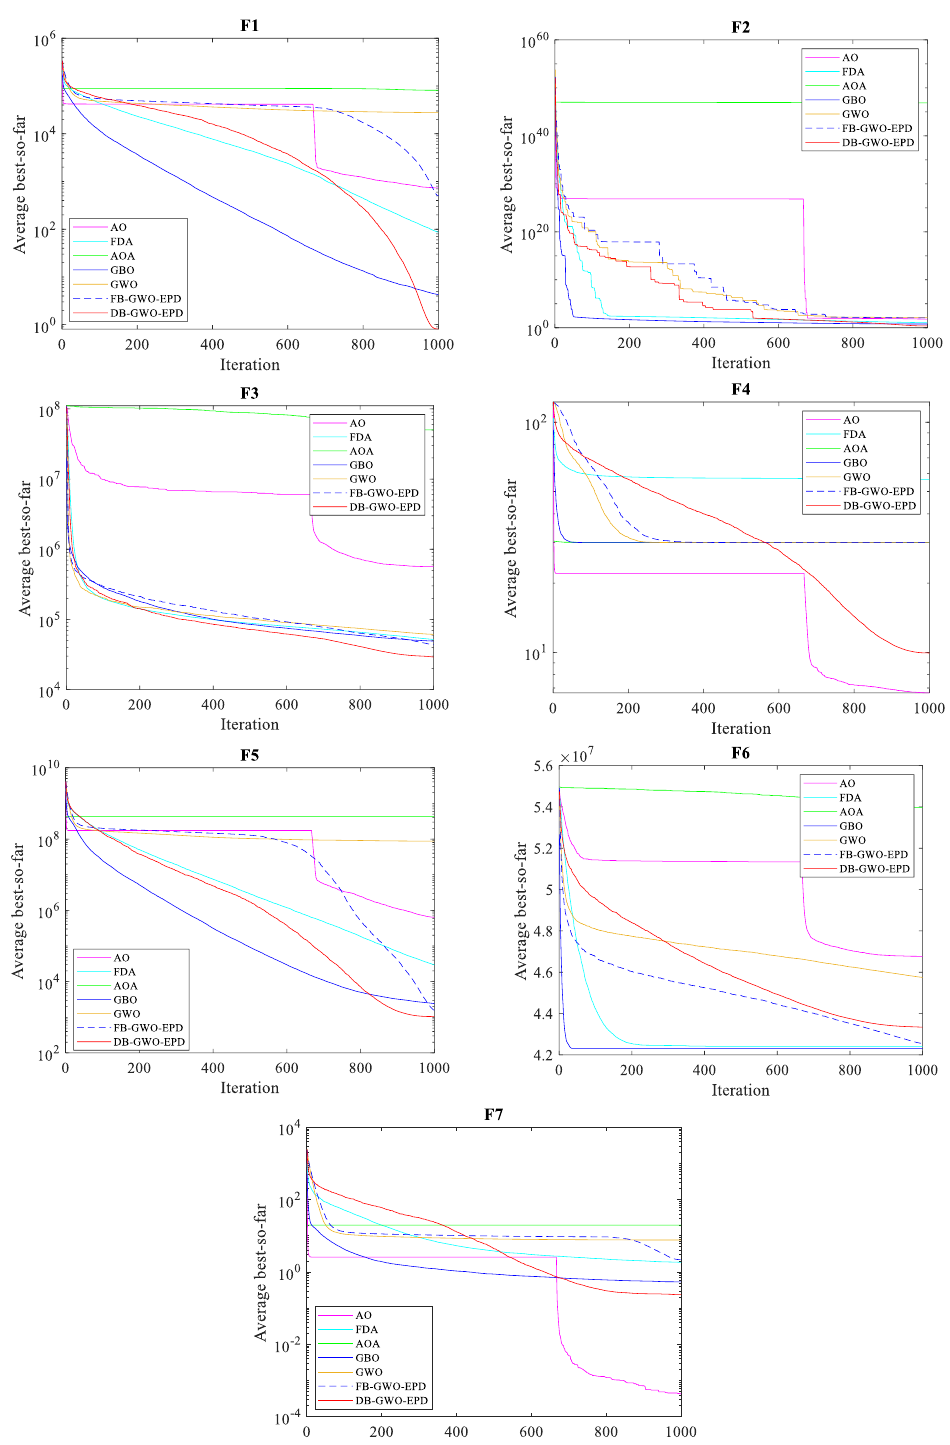
Figure 2. Convergence curves plotted for the algorithms on the uni-modal shifted benchmark functions.